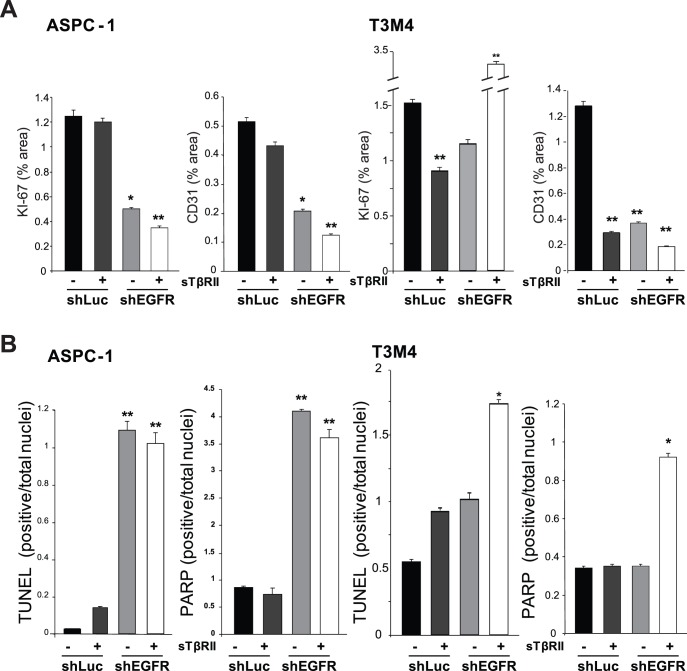
Effects of targeting EGFR and TGF-β pathways on proliferation, angiogenesis and apoptosis.A. The ASPC-1- and T3M4-derived tumors described in figure 2 were immunostained for Ki67 to assess proliferation and CD31 to assess angiogenesis. B. The same tumors were scored for TUNEL-poisitive cells and cleaved PARP immunoreactivity to assess apoptosis. Data are the means ± SEM of triplicate determinations from three independent experiments. *p<0.05, and **p<0.01, when compared with respective controls.